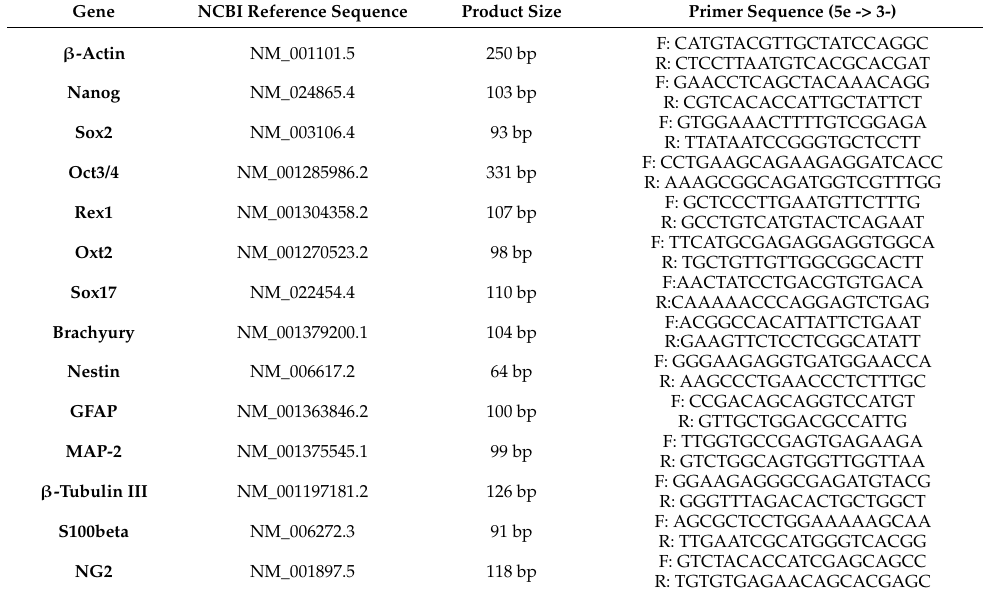
Table 4. Primer sequences used in qRT-PCR